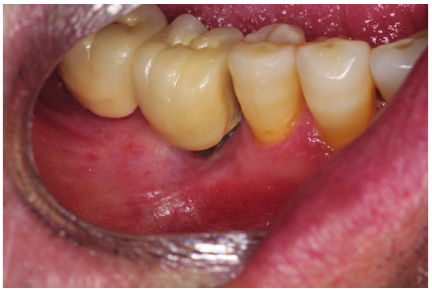
Figure 6: 12-month postexcision follow-up of the lesion located in